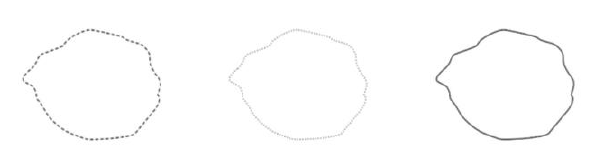
Figure 16: Attached, Alienated and Aggression Group Boundaries Those for whom aggression was the norm may well have the solid line boundary of a rigid, impenetrable boundary because attention had to be focused on protecting self from aggression within the family so there was no energy available to look outside the